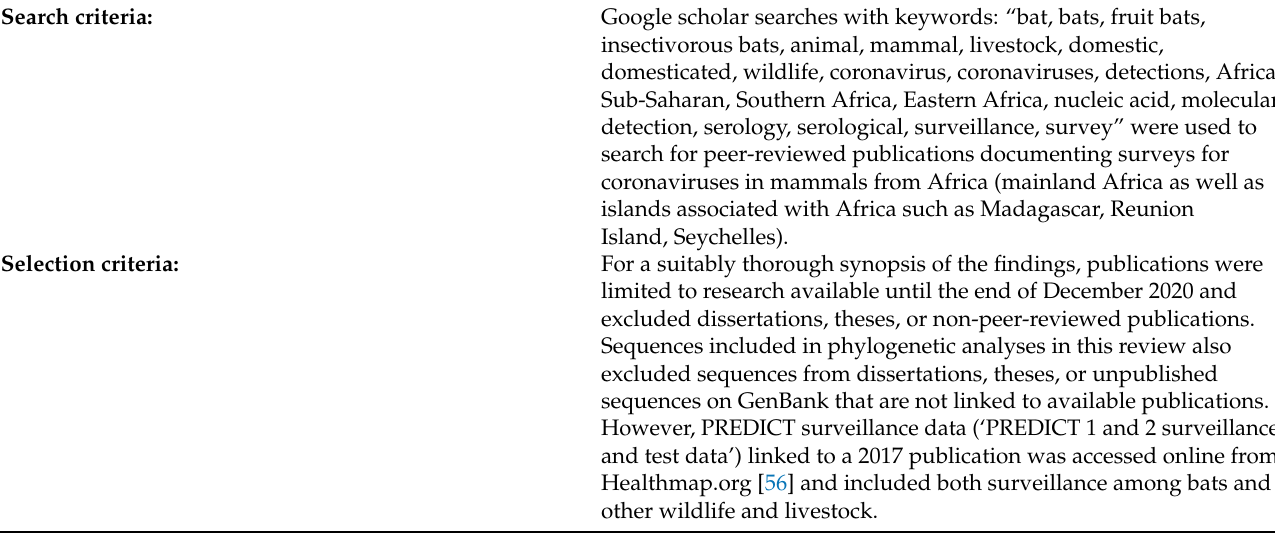
Table 1. Selection and classification criteria of studies included in the